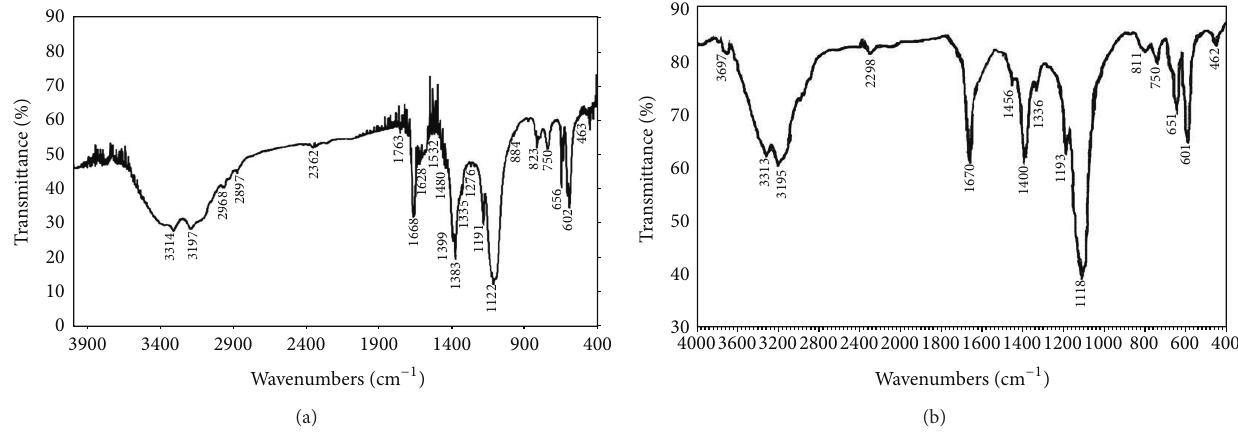
Figure 8: FTIR spectra of silver nanoparticles synthesized by using leaf (a) and stem extract (b) of Piper